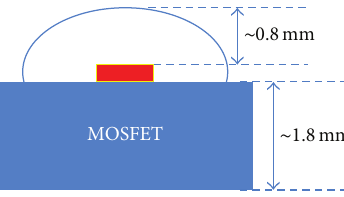
Figure 2: Schematic of typical MOSFET with conventional epoxy bubble.